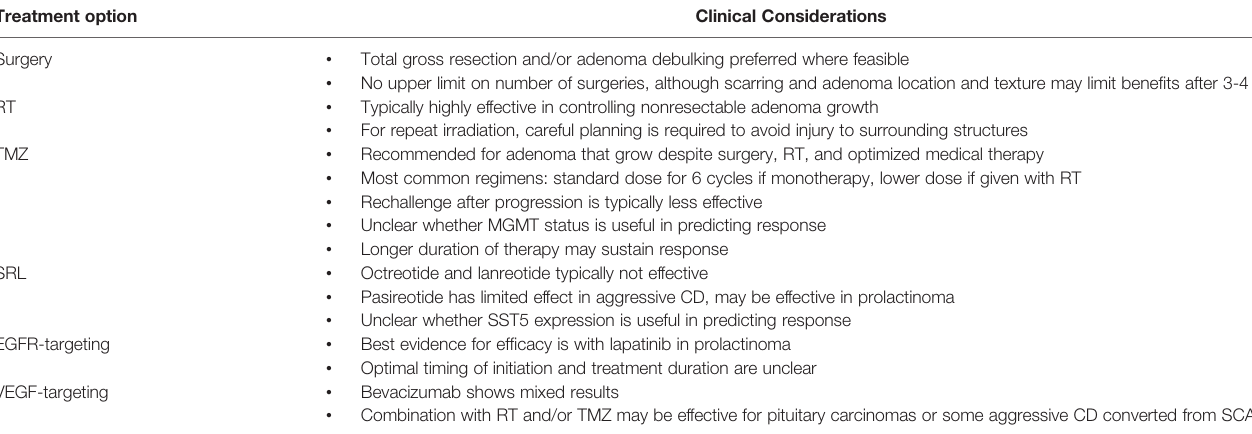
TABLE 4 | Summary of treatment